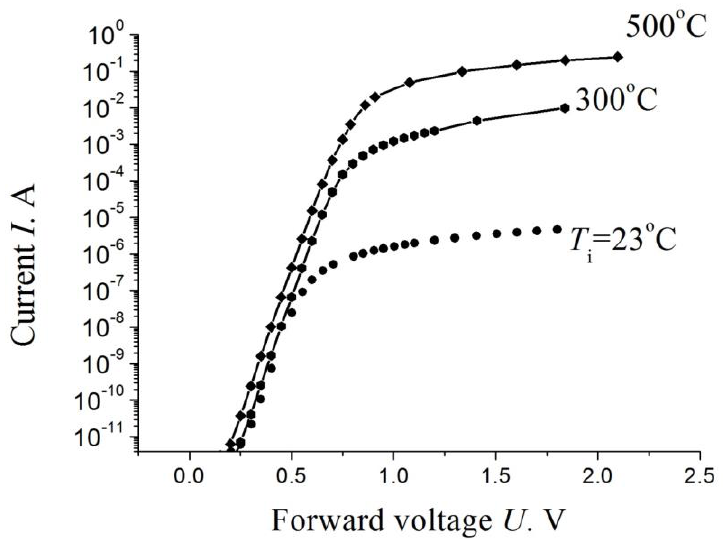
Figure 10. Forward current–voltage characteristics of diodes upon their irradiation with 0.9 eV electrons at three different irradiation temperatures T i . the dose Φ ≈ 6 × 10 16 cm − 2 . The inset shows how the base resistivity ρ depends on the inverse irradiation temperature [47].